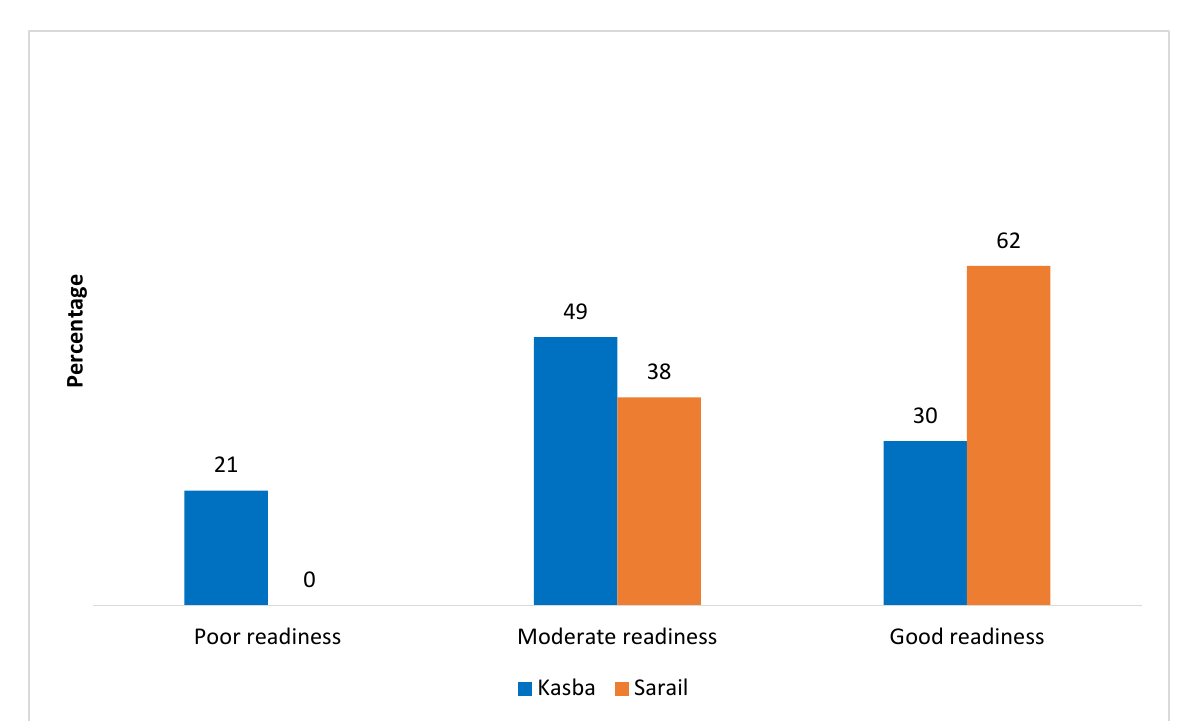
Figure 2. Accessibility status of CCs at Kasba (n = 33) and Sarail (n = 21). Data from 5/33 CCs were missing (staff absent in four CCs and one CC was destroyed).